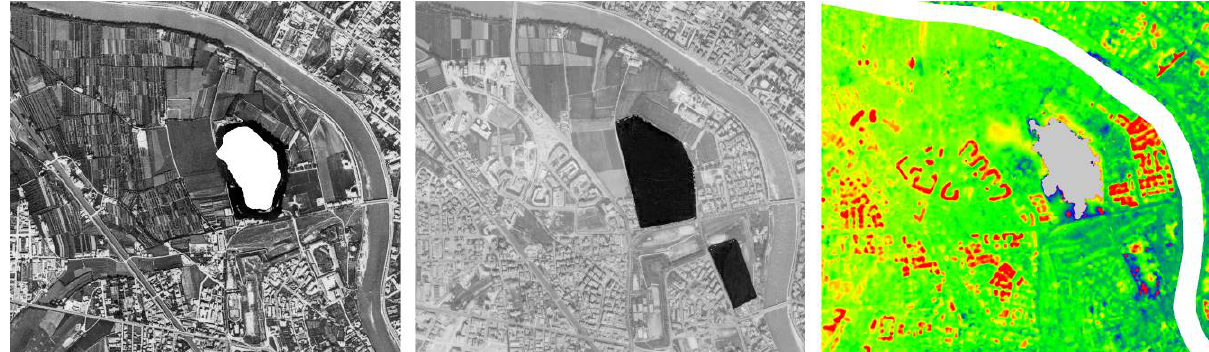
Figure 4: detail of an area: in 1954 it was unbuilt (left) in 1981 there were new buildings. On the right the difference